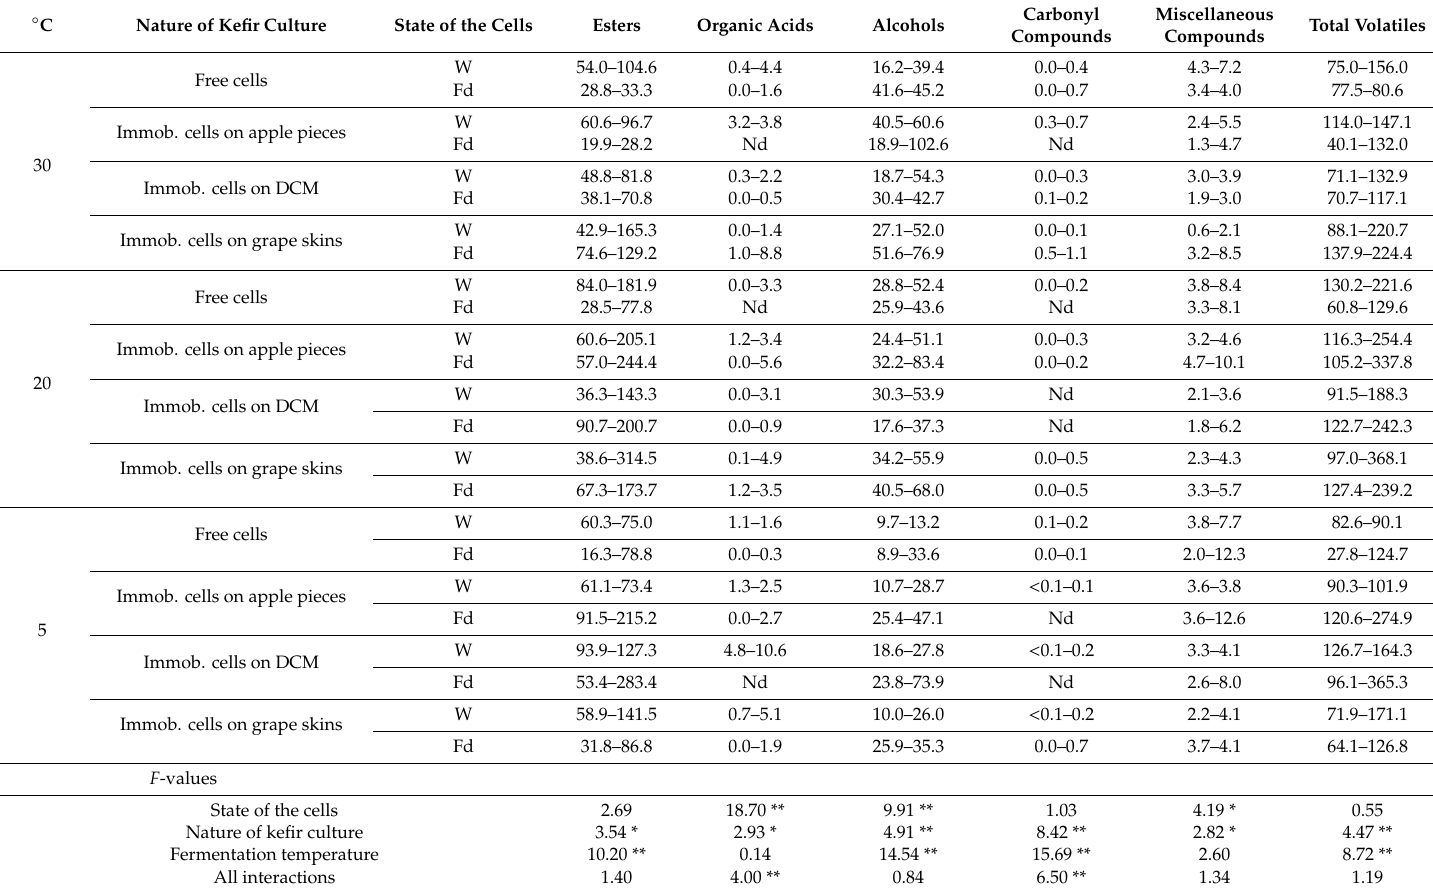
Table 5. Minor volatile compounds (mg / L) identified in low alcohol wines produced by wet or freeze-dried kefir culture at 5–30 ◦ C using the headspace solid-phase microextraction gas chromatography–mass spectrometry (HS-SPME / GC-MS) analysis. Volatiles were semi-quantified using 4-methyl-2-pentanol as the internal